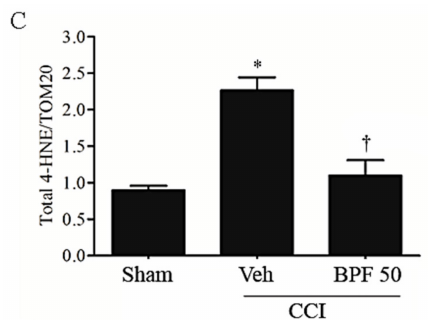
Figure 3. The development of hyperalgesia and allodynia coincided with an increase of 4-HNE level 14 days post injury. ( A ) CCI rats showed a significant production of 4-HNE in spinal cord 14 days post injury as measured by Simple Western (WES) methodology. Infusion of BPF (50 mg / kg), concurrently with surgery (day 0), showed a significant reduction of these values. ( B ) No di ff erence for TOM20 expression was detected among the lanes in these conditions. ( A , B ) Lanes and ( D ) electropherogram are representative of results from 6 di ff erent animals. ( C ) Densitometric analyses of all animals per groups are reported. Results are expressed as mean ± SEM for 6 rats. * p < 0.05 versus sham; † p < 0.05 versus vehicle +